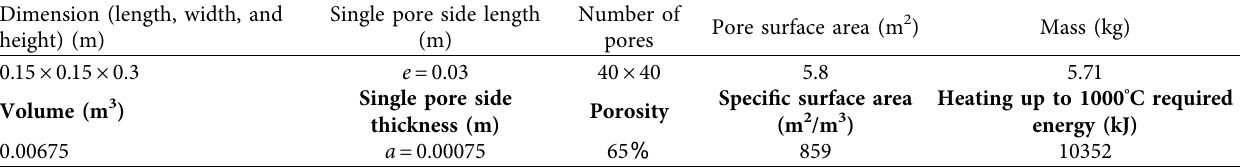
Table 1: Monolithic ceramic parameters.